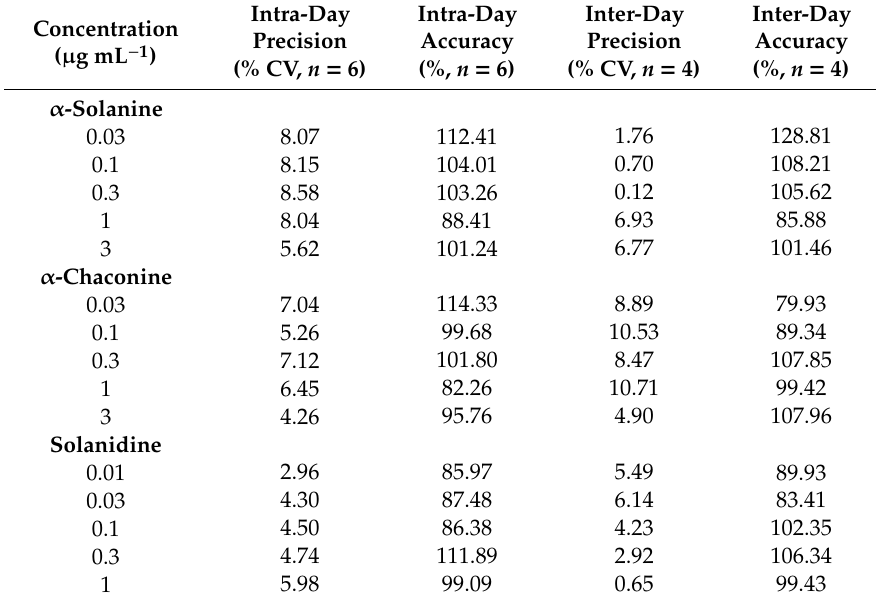
Table 3. Intra- and inter-day precision and accuracy of α -solanine, α -chaconine, and solanidine standards. Concentration ( µ g mL − 1 )